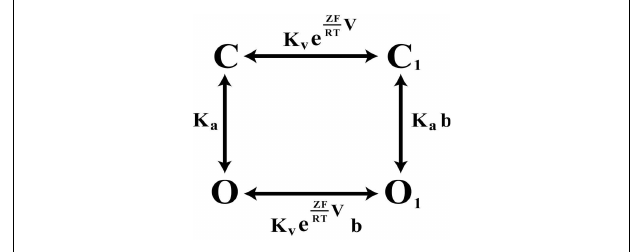
SCHEME 1 |The four-state allosteric gating scheme, illustrating the voltage-dependent (horizontal) and voltage-independent (vertical) channel transitions. C and C1 signify the closed-states of the channel, O and O1 the open states,